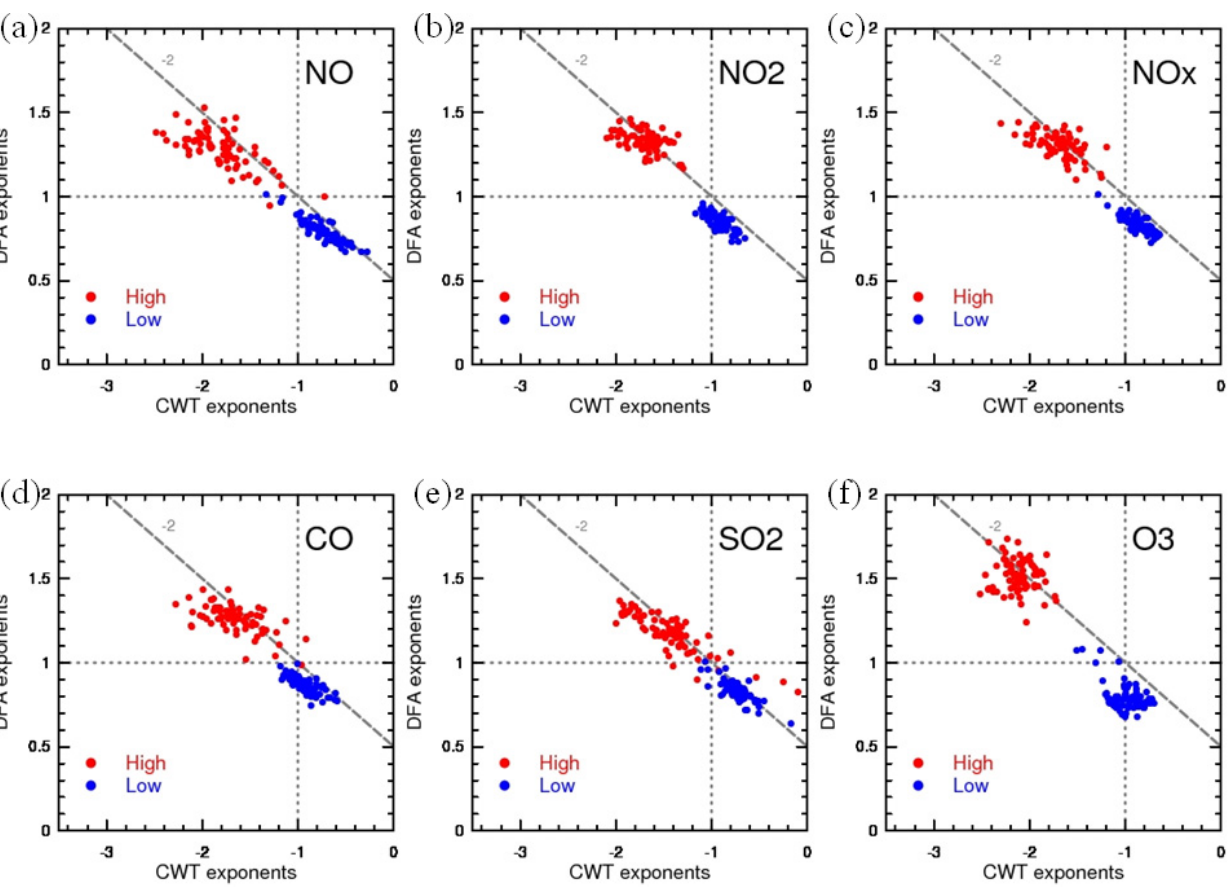
Fig. 5. The scatter plots of CWT and DFA exponents for the high-frequency band (red dots) and low-frequency band (blue dots) for the gases, NO (panel a ), NO 2 (panel b ), NO x (panel c ), CO (panel d ), SO 2 (panel e ), and O 3 (panel f ). The grey dash lines have a slope of −